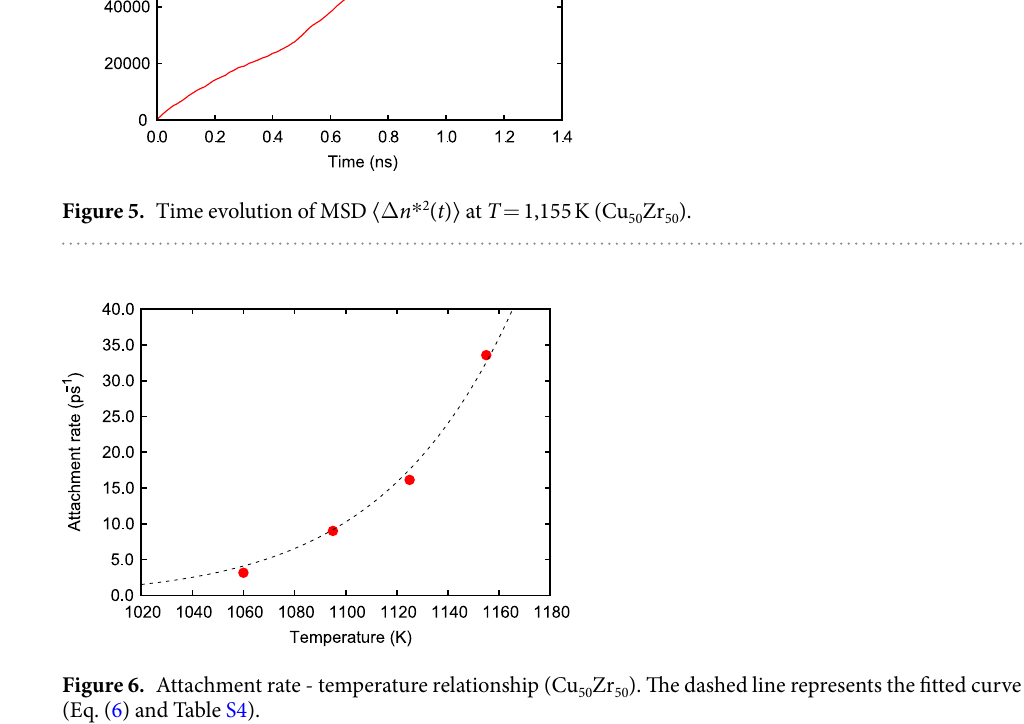
The temperature dependent nucleation rate J and the incubation time t are directly computed from Eq. (8). are computed and sum- The atomic number density of the melt ρ melt and that of the critical crystal nucleus ρ ⁎ crystal marized in Table 2 by taking the average volume of simulation cell V ( N = 16,000) with PBC over 100 ps NPT ensemble MD simulation at the critical temperature and a zero pressure condition. The Zeldovich factor Z is estimated by using Eqs. (18) and (19). With the exception of the parameters obtained in the previous sections, the attachment rate f + that appears in the pre-exponential factor J 0 (Eq. (19)) is still unknown, and thus it is necessary to obtain J . In order to compute the attachment rate, 4 ns NPT ensemble MD simulations on the same melt - spherical crystal model with r = r * ( T ) used in the previous analysis are performed at different temperatures rang- ing from 1,060 to 1,160 K under a zero pressure condition. The number of atoms belonging to the embedded crystal, Δ n * ( t ) = n * ( t ) − n * (0), are recorded during the MD simulations. This is followed by obtaining the MSD 〈 Δ n * 2 ( t ) 〉 and attachment rate (Eq. (20)). It should be noted that ten independent MD simulations are performed for each temperature, and they are averaged to reduce the statistical error. Figure 5 shows time evolution of the MSD for Cu 50 Zr 50 at T = 1,155 K. The slope of the MSD-time plot corresponds to twice that of the attachment rate, 2 f + ( n * ). The computed attachment rates are plotted in Fig. 6 for Cu 50 Zr 50 and are summarized for both alloys in Table 2. The attachment rate increases with increases in the temperature. The attachment rate of Cu 20 Zr 80 is an order of magnitude higher than that of Cu 50 Zr 50 . The computed attachment rate is used to eventually compute the nucleation rate J of unit volume and summarize it in the Table 2. The nucleation rate rapidly increases with increases in the temperature. The rapid change in the nucleation rate is mainly attributed to the exponential term in Eq. (19) as opposed to the pre-exponential factors. As previously stated, the direct MD analyses of the attach- ment rate f + ( n * ) are only performed above T = 1,060 K because a large statistical error due to the lower number of samples is expected below this temperature. In order to predict the attachment rate at low temperatures, the following Arrhenius type exponential function fitted to high temperature MD data of the attachment rate is used instead of performing direct MD analysis at the low temperatures.